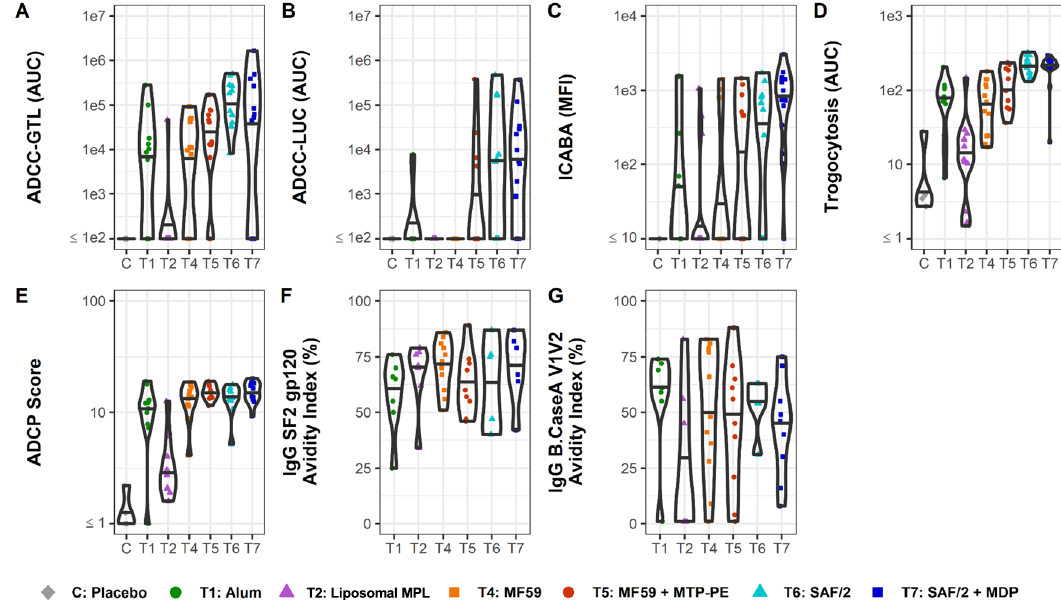
Fig. 2 Antibody effector function and avidity 2 weeks post fi nal vaccine dose. A – D Effector Functions. Antibody dependent cellular cytotoxicity-GranToxiLux (ADCC-GTL) area under the curve (AUC) ( A ), antibody dependent cellular cytotoxicity Luciferase (ADCC-LUC) area under the curve (AUC) ( B ), Infected Cell Antibody Binding Activity (ICABA) in mean/median fl uorescence intensity (MFI) ( C ), Trogocytosis AUC ( D ), antibody-dependent cellular phagocytosis (ADCP) score ( E ), and antibody avidity to SF2 ( F ) and V1V2 from clade B Case A strain ( G ). Avidity ( F and G ) is shown only for participants with a positive vaccine-induced binding response (see Methods for details). Individual vaccine recipients are indicated by dots, and violins plots present group distributions, with median values indicated with a